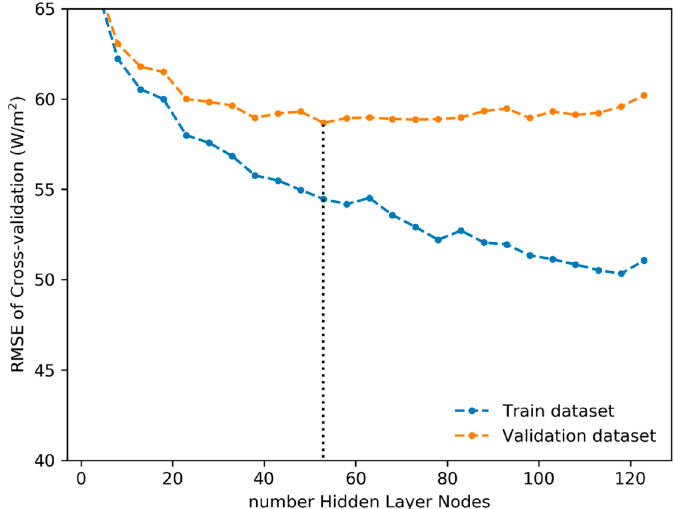
Figure 6. Cross-validation RMSE of the Artificial Neural Network (ANN) method with a different number of nodes in the hidden layer.